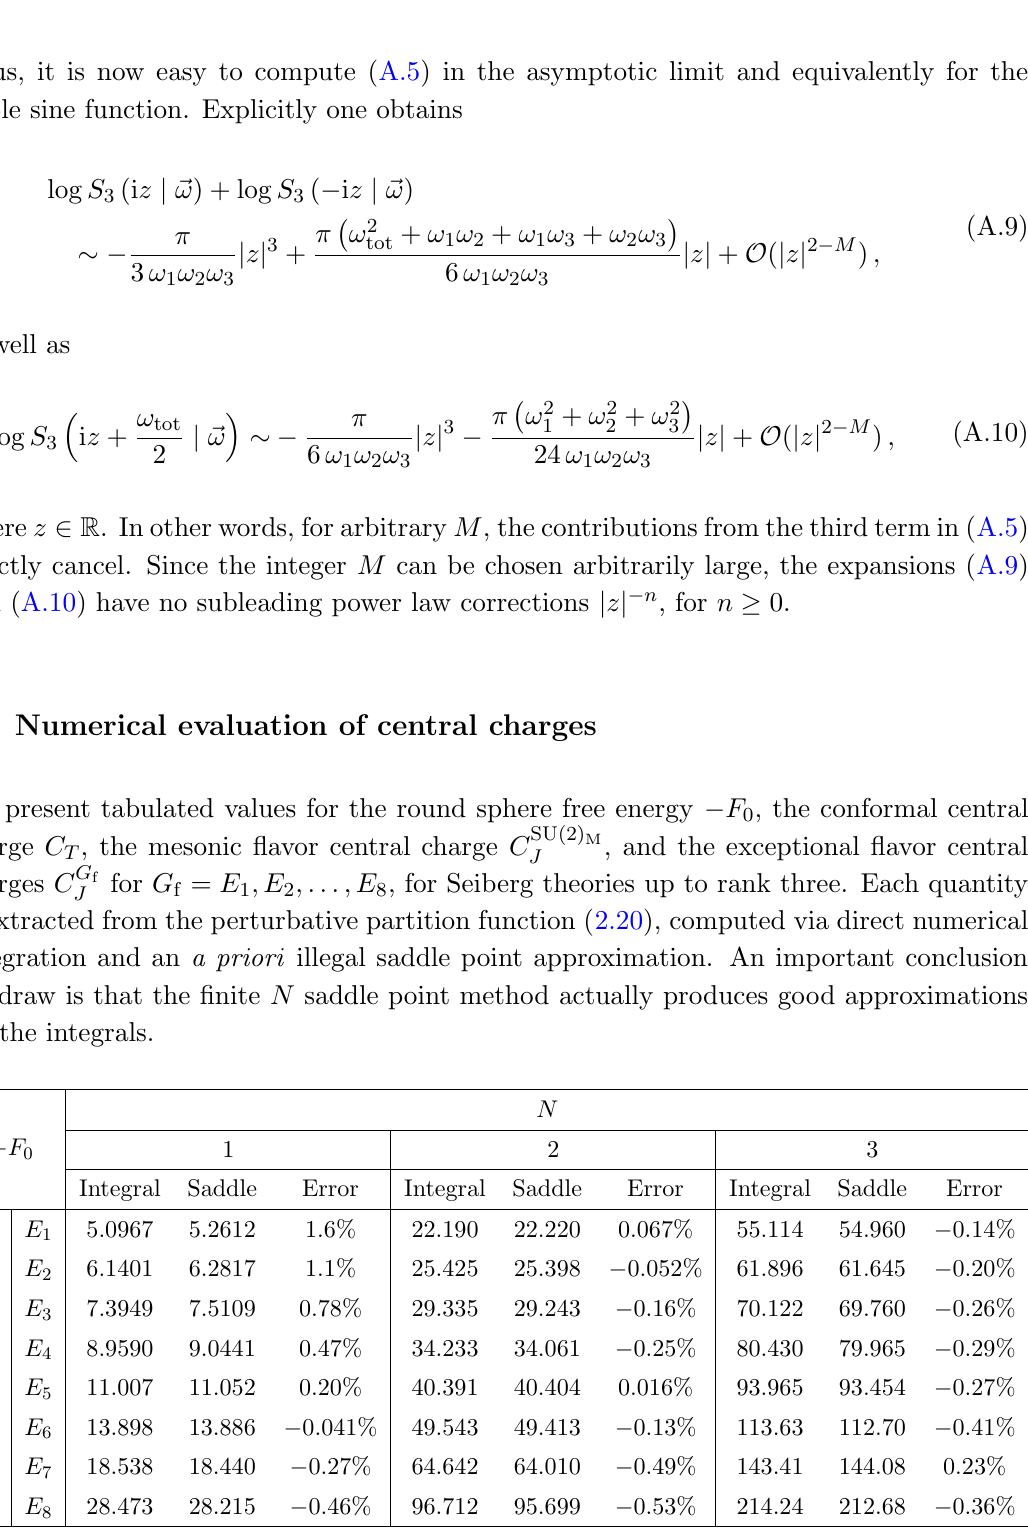
0 in the rank-one to rank-three